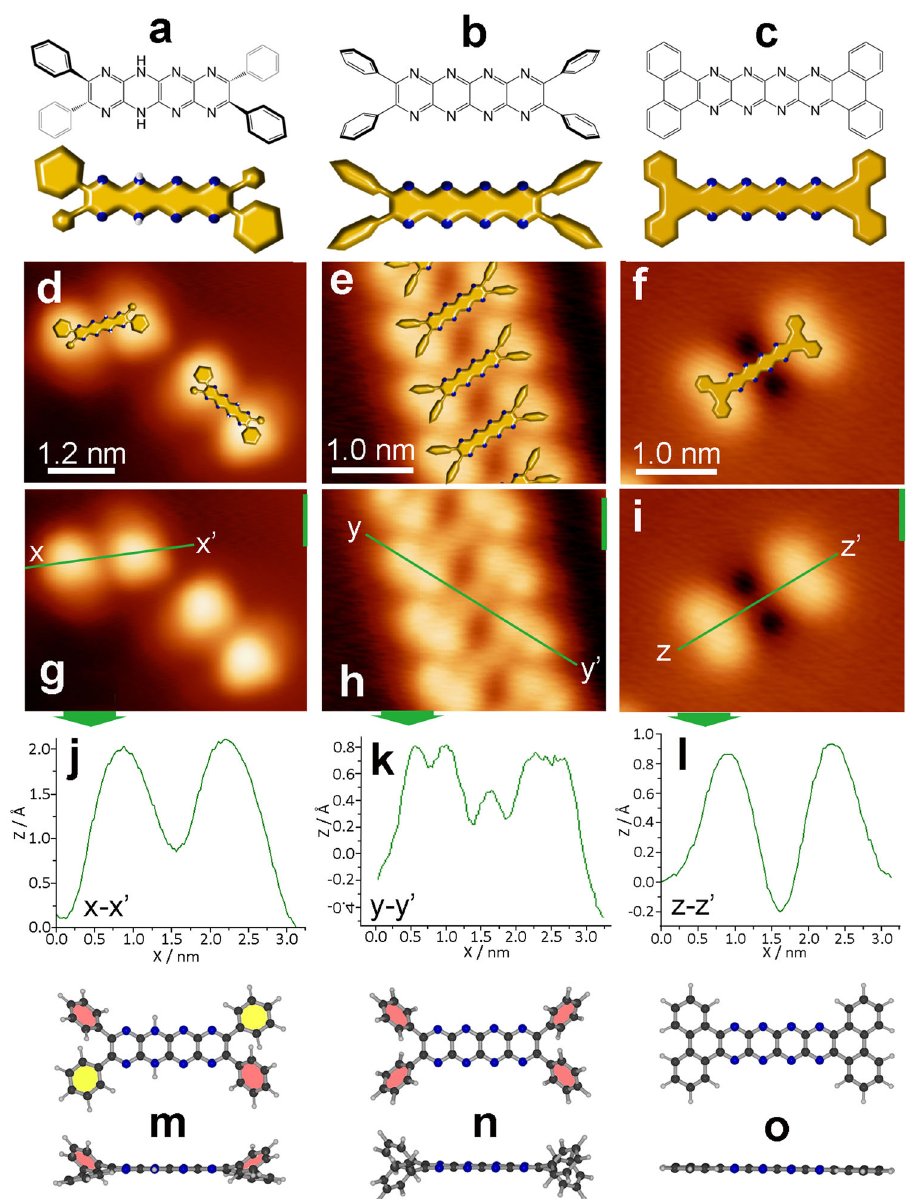
Fig. 3 Summary of chemical species observed in the STM micrographs of 2. Line drawing and model representation of a 2 , b 2 -ox, c 2 -ox 2 . STM images overlaid with the models of d 2 , e line structure of 2 -ox, f 2 -ox 2 . STM images of g 2 , h 2 -ox, i 2 -ox 2 with accompanying pro fi le data shown respectively in j – l . STM pro fi les are consistent with chemical structures given in m 2 , n 2 -ox, o 2 -ox 2 where different z-displacements can be associated with different dihedral angles between phenyl substituents and pyrazinacene backbone (solid pink shading — high phenyl dihedral angle ~50°; solid yellow shading — low phenyl dihedral angle ~10°). In o , cyclodehydrogenation at phenyl ortho positions leads to molecular planarization and an overall low STM pro fi le. Line structures of 1 -ox have additional features which are discussed in Supplementary Figs. 13 &